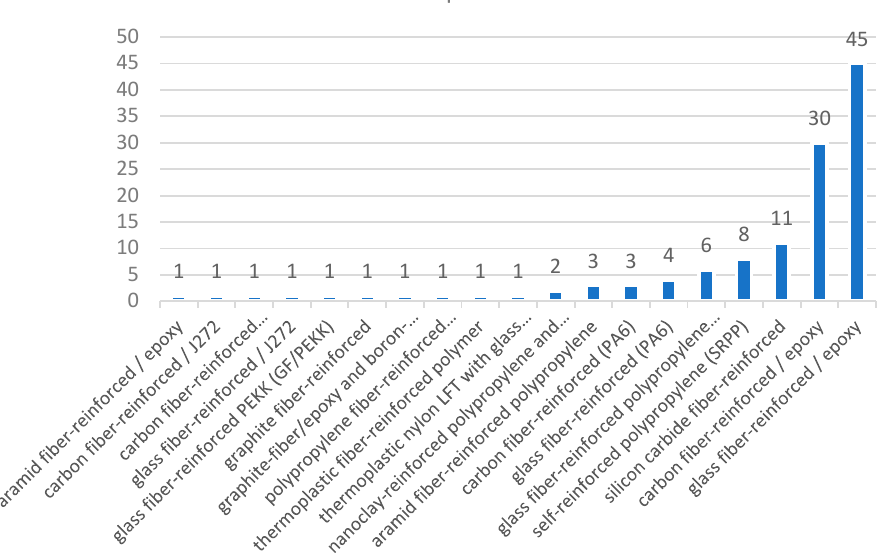
Figure 3. Reinforced composite used in FMLs.